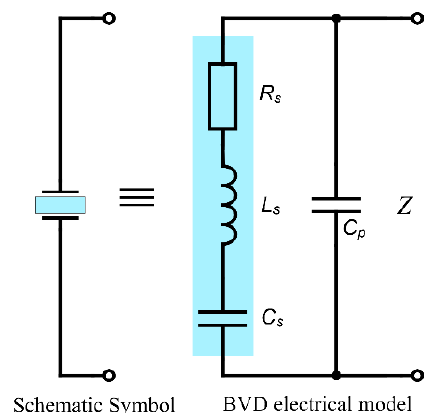
Figure 1. Butterworth van Dyke (BVD) model for quartz crystal used as QCM sensor.